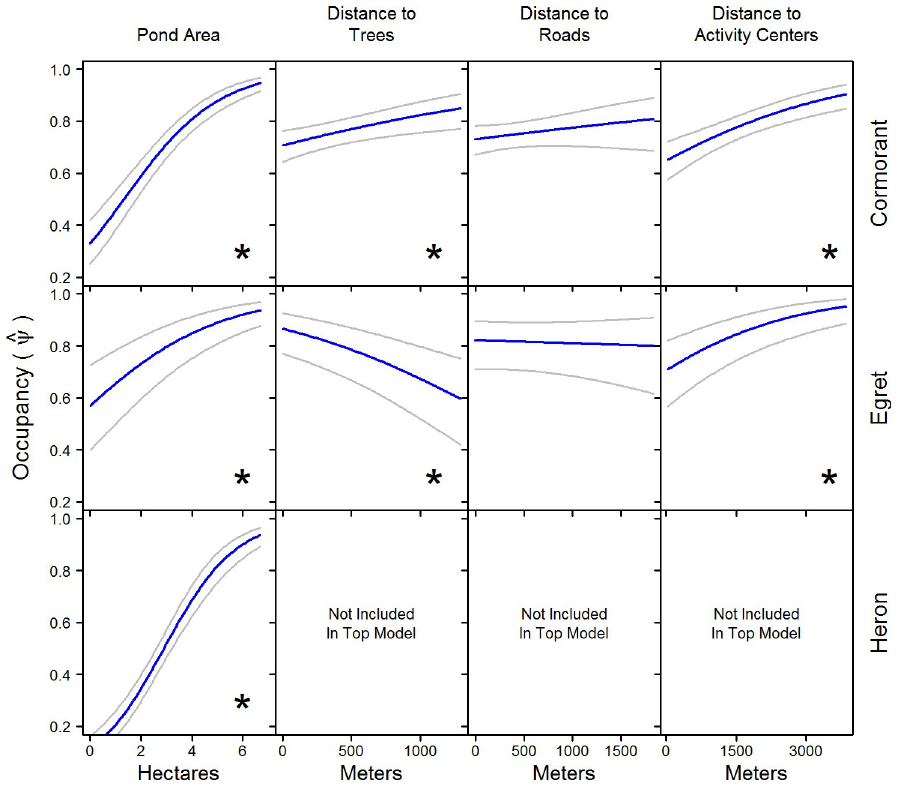
Fig 3. Occupancy probability (+ 95% CI) of catfish ponds in the Mississippi Delta based on continuous variables included in the top ranked models for cormorants, egrets, and herons. Occupancy was estimated from the model by allowing the variable of interest to vary over its range while holding all other variables at their mean. Plots displaying an asterisk ( � ) indicate a significant result within the model based on an alpha of 0.05.